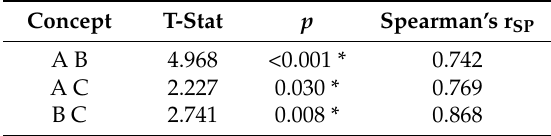
Table 3. Inferential statistics of usefulness scale with Connover’s post-hoc test and Spearman’s